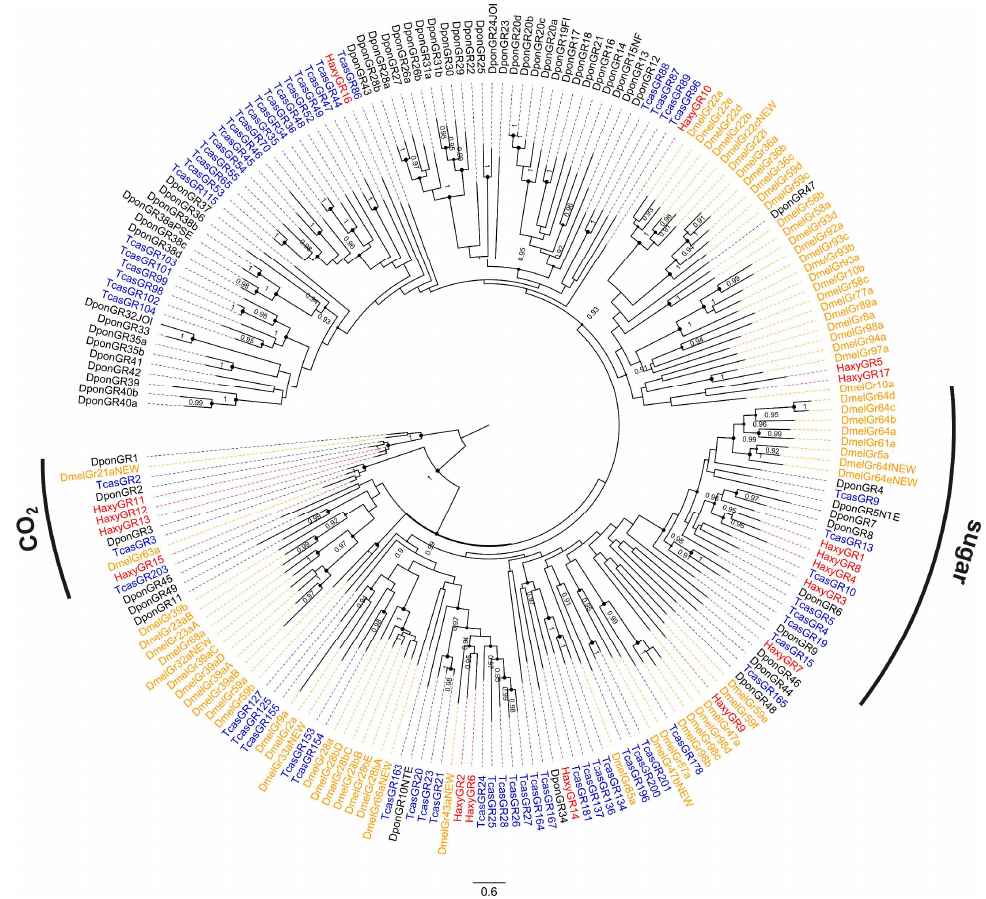
Figure 2. Phylogenetic tree of gustatory receptors (GRs). Red: Harmonia axyridis (Haxy); blue: Tribolium castaneum (Tcas); orange: Drosophila melanogaster (Dmel); black: Dendroctonus ponderosae (Dpon). Numbers and symbols at nodes represent support values higher than 0.9, where 1 represents maximal support.